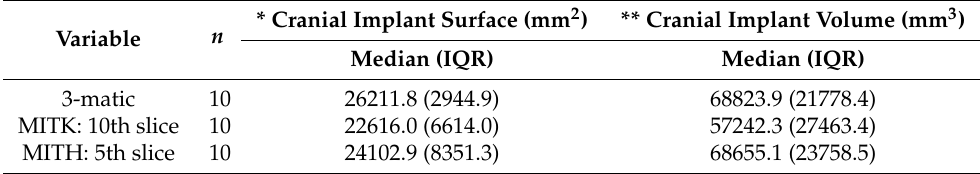
Table 1. The cranial implant surface and volume for three different methods.